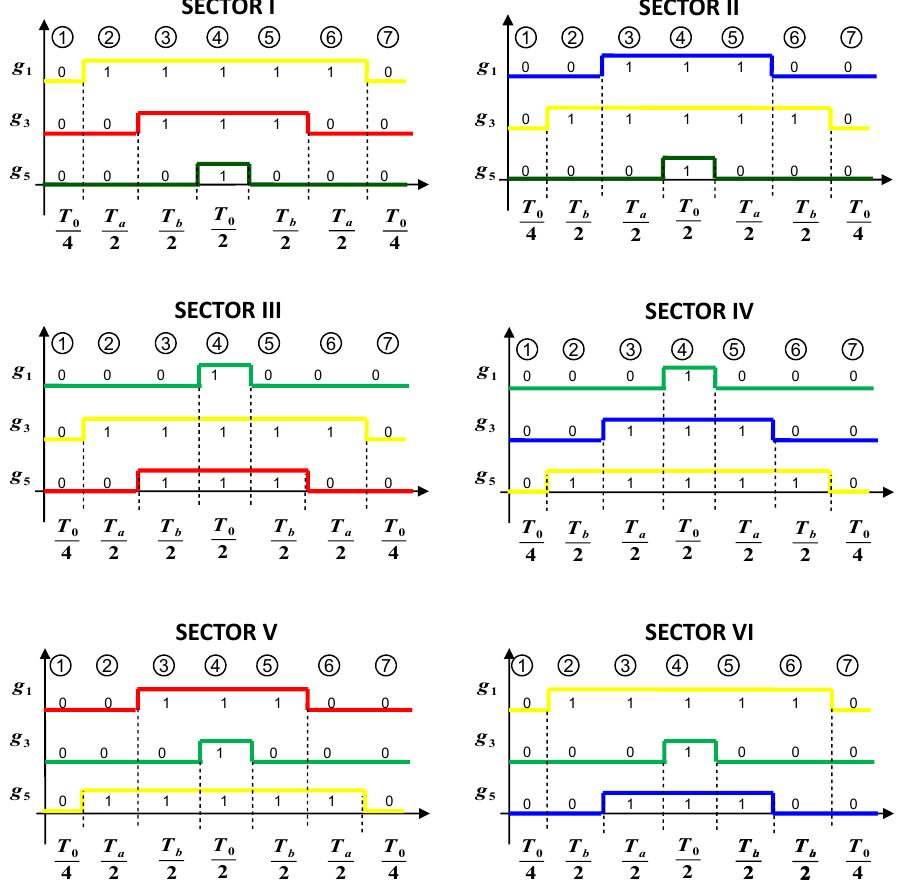
Figure 4. Time diagrams for each sector.